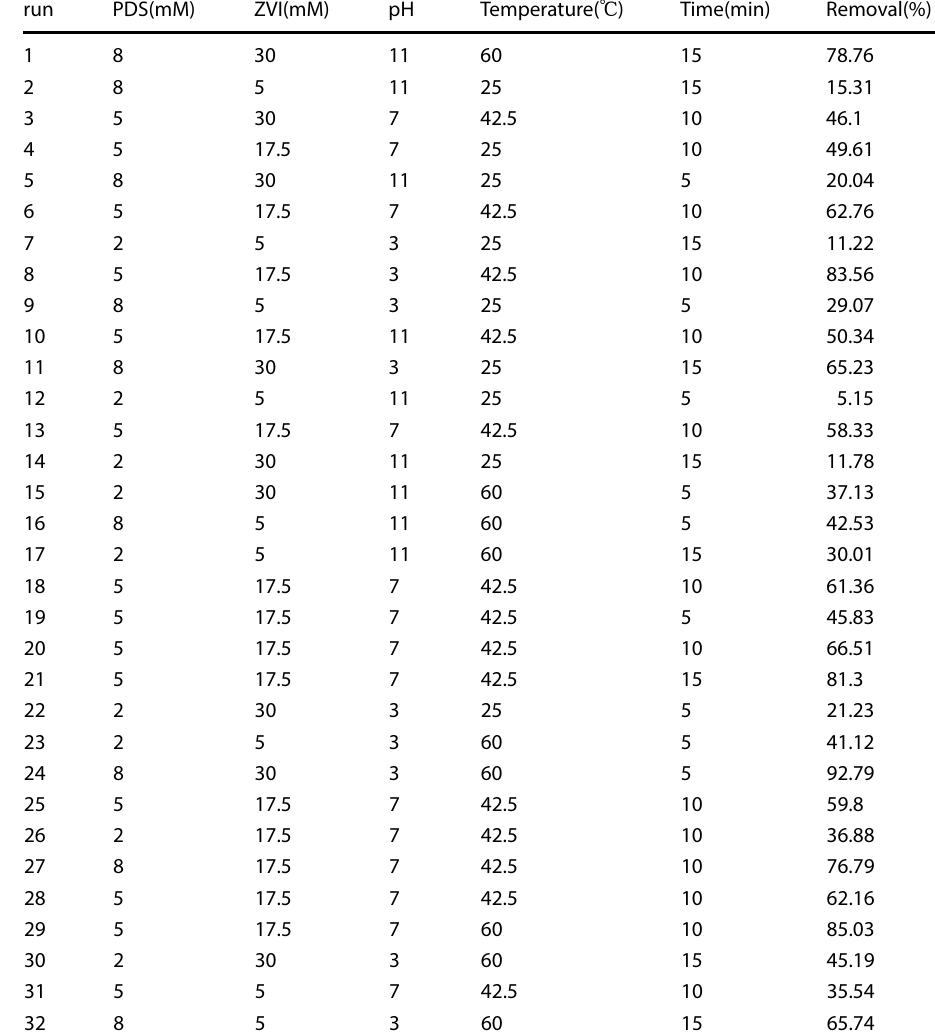
Table 2 Full factorial CCD matrix and Experimental AMR removal efficiency